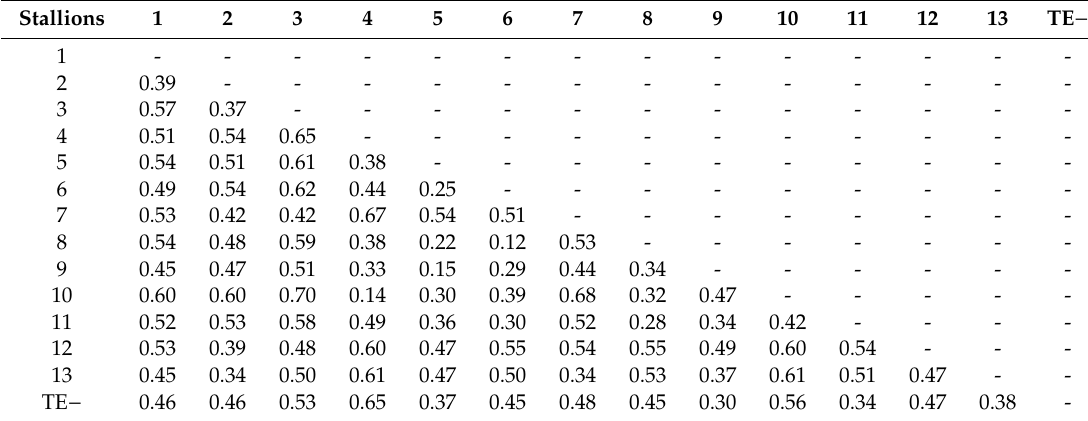
Table 2. Bray-Curtis dissimilarity indexes for the second batch.